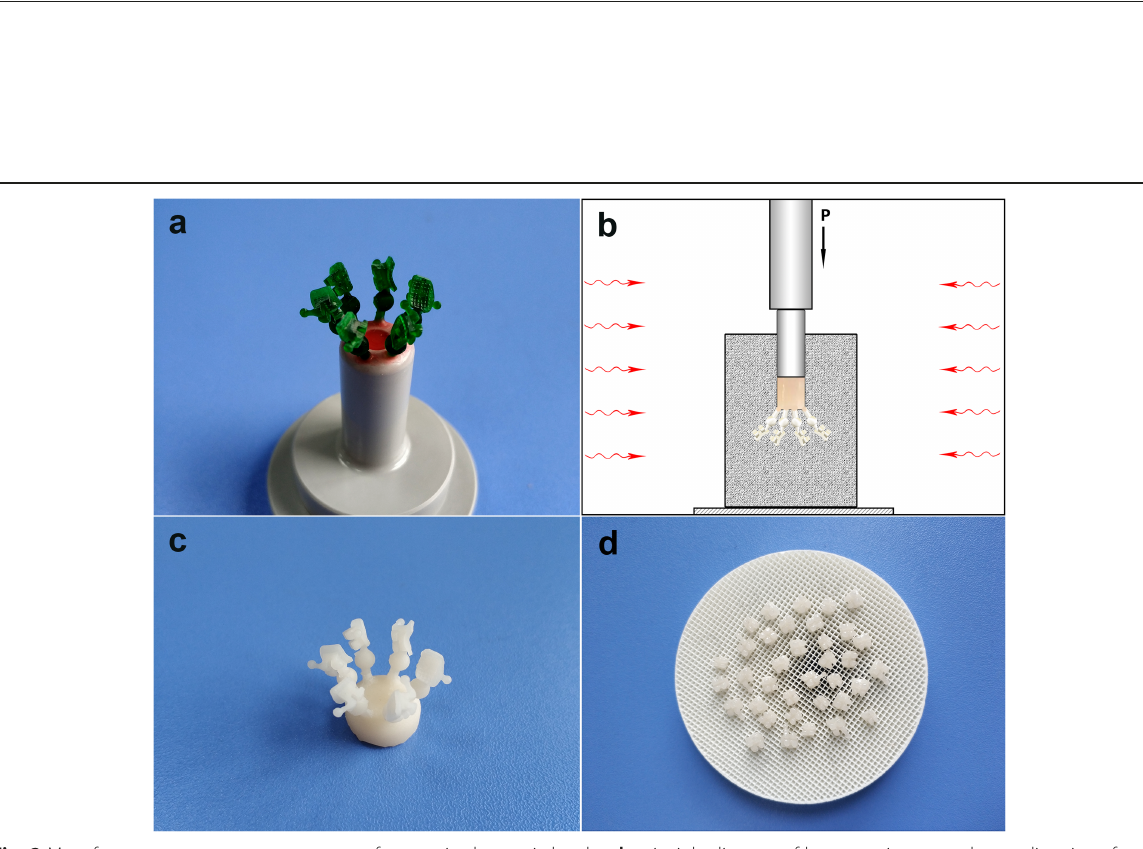
Fig. 2 Manufacture processes: a wax patterns of customized ceramic bracket; b principle diagram of heat-pressing procedure; c divesting after heat-pressing; d sintering after